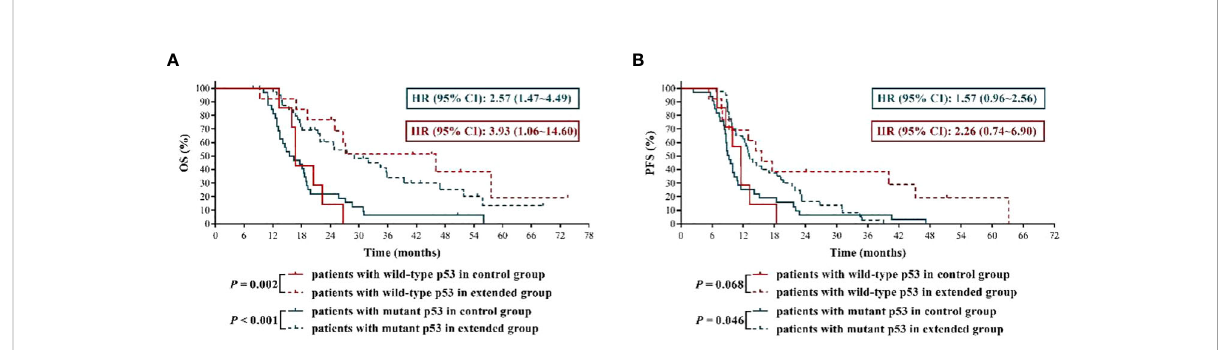
FIGURE 5 The effects of extended adjuvant temozolomide chemotherapy on the clinical outcomes of newly diagnosed glioblastoma patients with different p53 mutation statuses. (A) The Kaplan − Meier survival curves for overall survival. (B) The Kaplan − Meier survival curves for progression- free